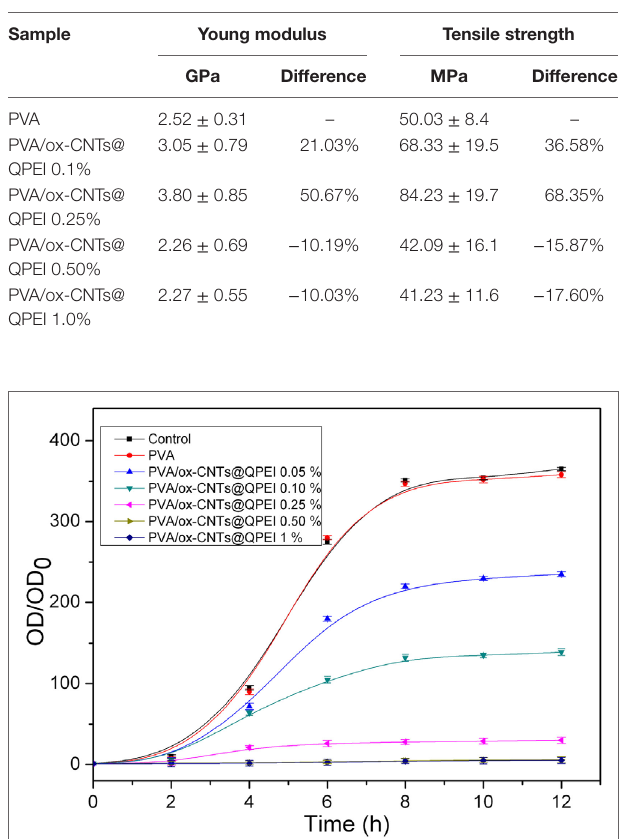
Table 2 | Mechanical properties of poly(vinyl alcohol) (PVA) and nanocomposite films.